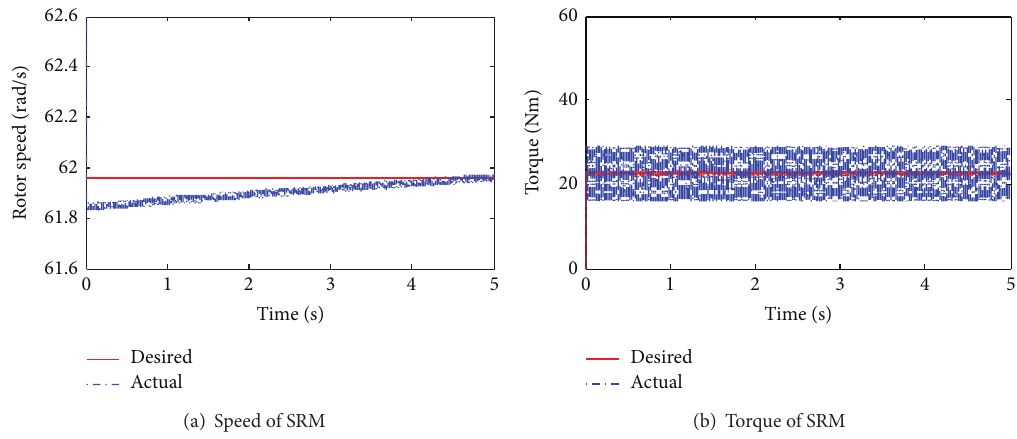
Figure 5: Comparison of actual and desired value of SRM response at velocity